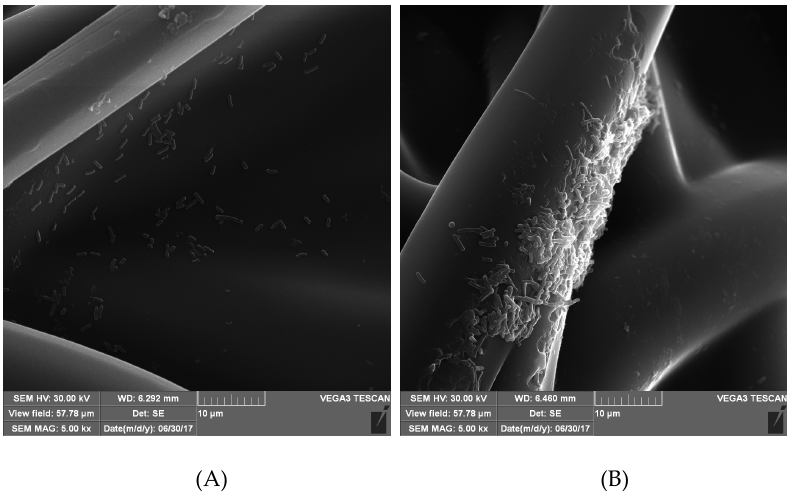
Figure A1. SEM photomicrographs of the Uni-Graft prosthesis surface ( A ) modified with α 1 -AT and ( B ) unmodified, after incubation with Candida albicans cells.